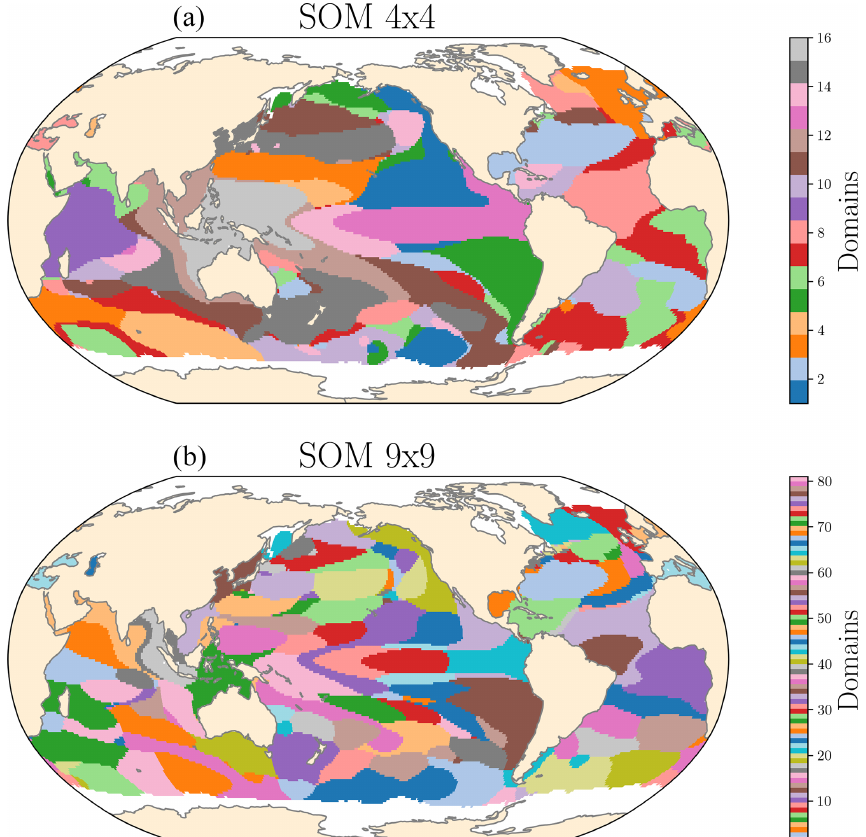
Figure A8. SOM domains for a neural map of 4 × 4 (a) and of (b) 9 × 9, using the entire ocean as input for the clustering. Note that even with a larger neural map the SOM patterns are still different from the δ -MAPS domains (Fig. 2), proving that the differences between the extracted patterns are not just a function of the number of SOM neurons but are due to differences between the two methods. It does, however, leads to fewer regions that are geographically distant being clustered in the same